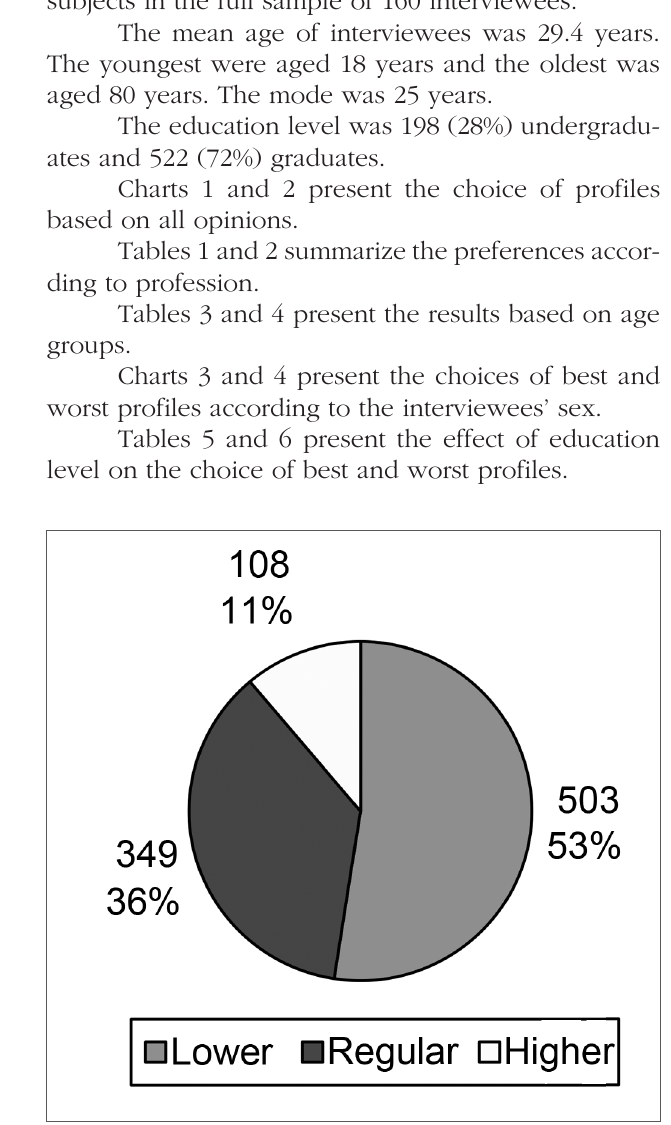
Chart 1. Best profiles without taking into account the group of profes- sional experience to which interviewees